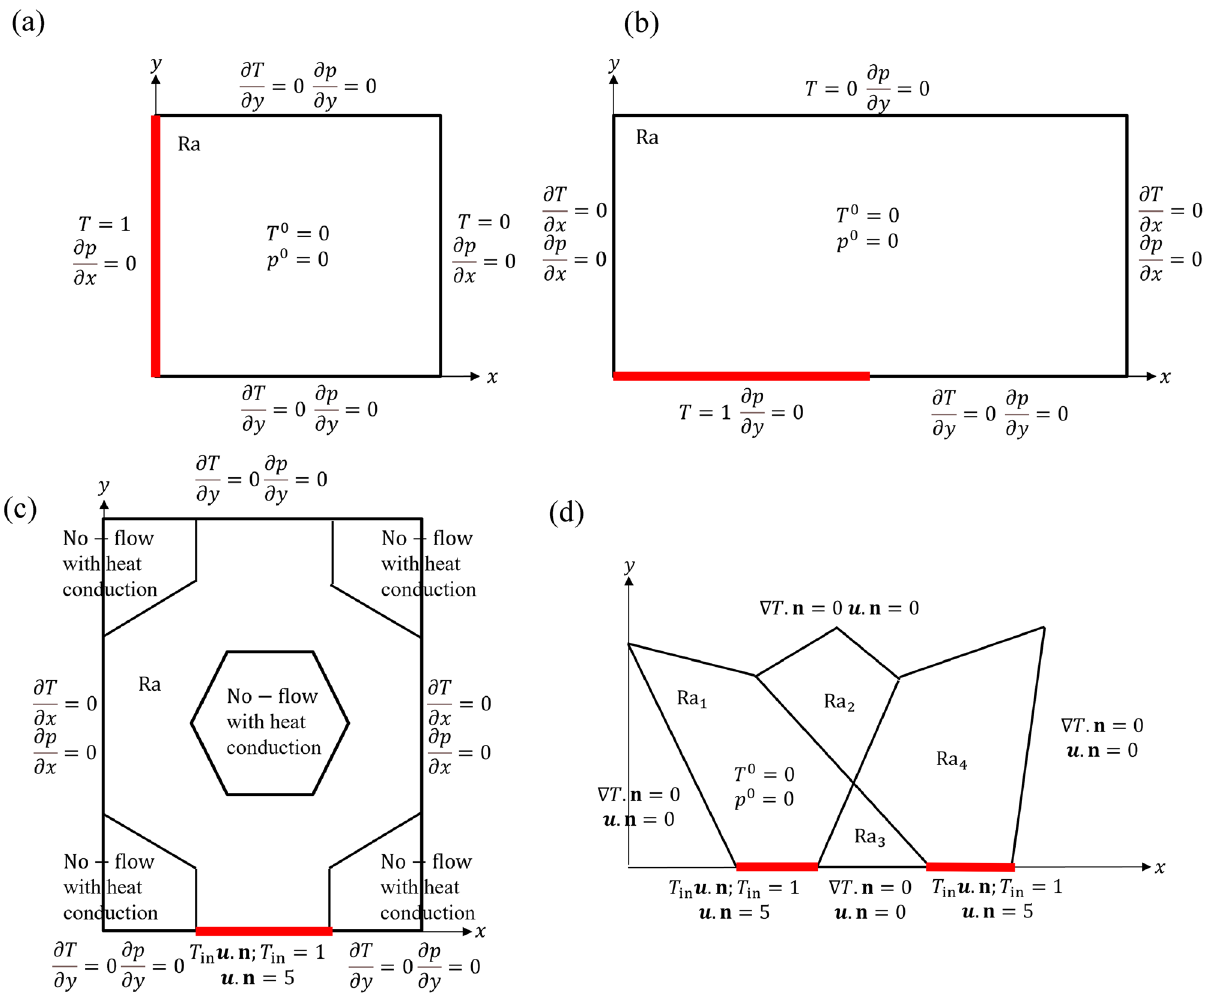
Figure 1. Domain and boundary conditions for ( a ) Example 1 (heating from the left boundary), ( b ) Example 2 (Elder problem), ( c ) Example 3 (unit cell of micromodel), and ( d ) Example 4 (modified Hydrocoin with four subdomains). The red line indicates the region of the boundary where the temperature is elevated.